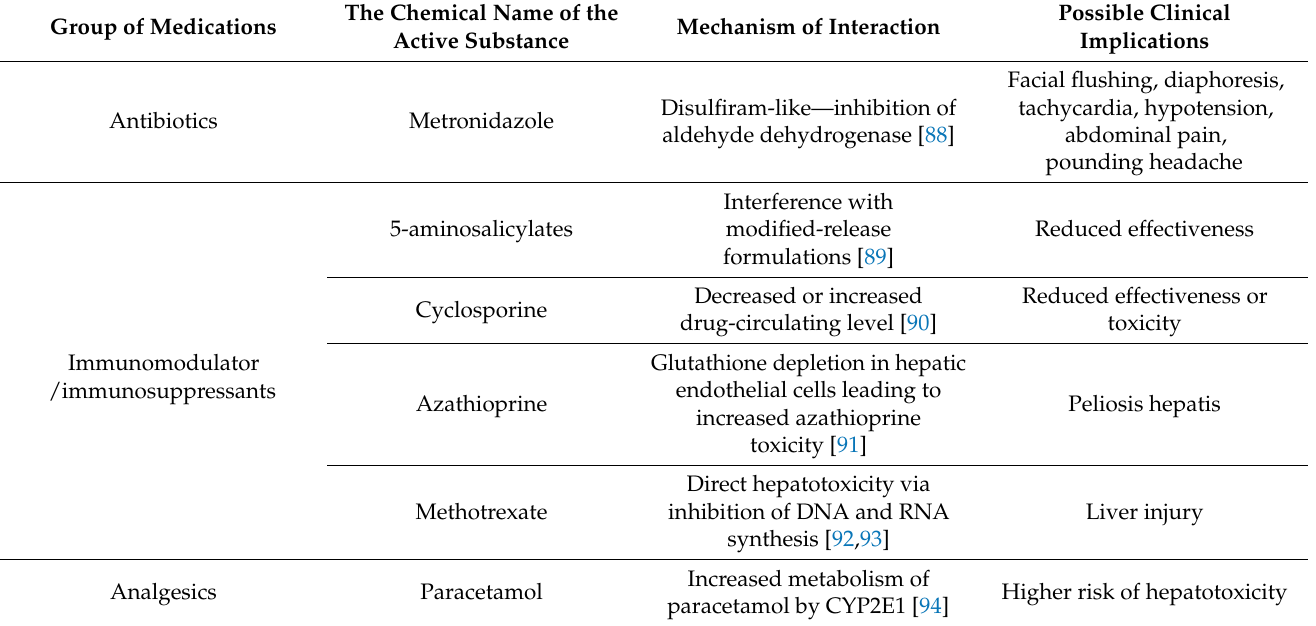
Table 4. Interactions of IBD-specific medications with